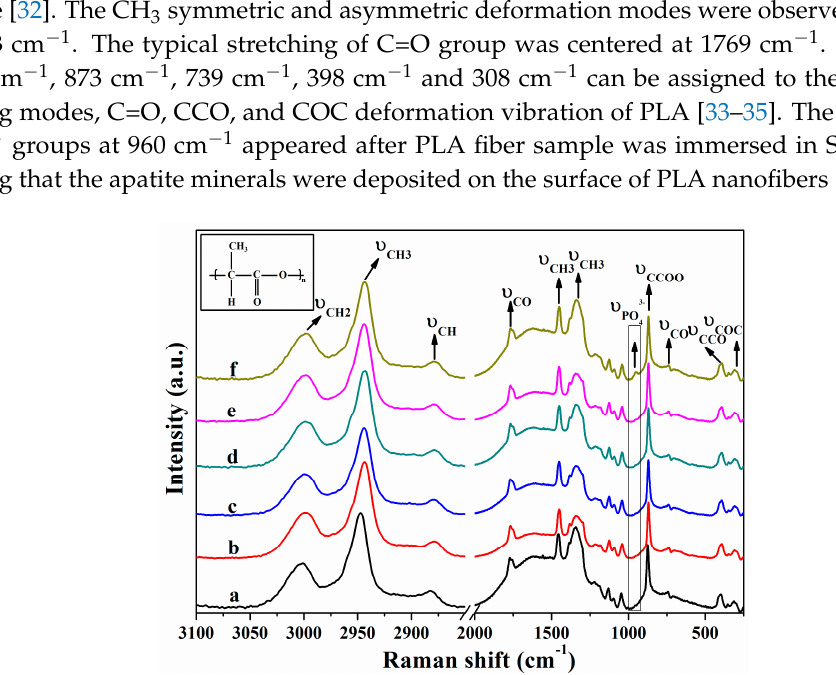
Figure 2. Raman spectra of PLA in the range of 250–2000 cm − 1 and 2850–3100 cm − 1 by being soaked in SBF for different time: ( a ) 0-day; ( b ) 1-day; ( c ) 3-day; ( d ) 5-day; ( e ) 7-day; ( f ) 21-day.